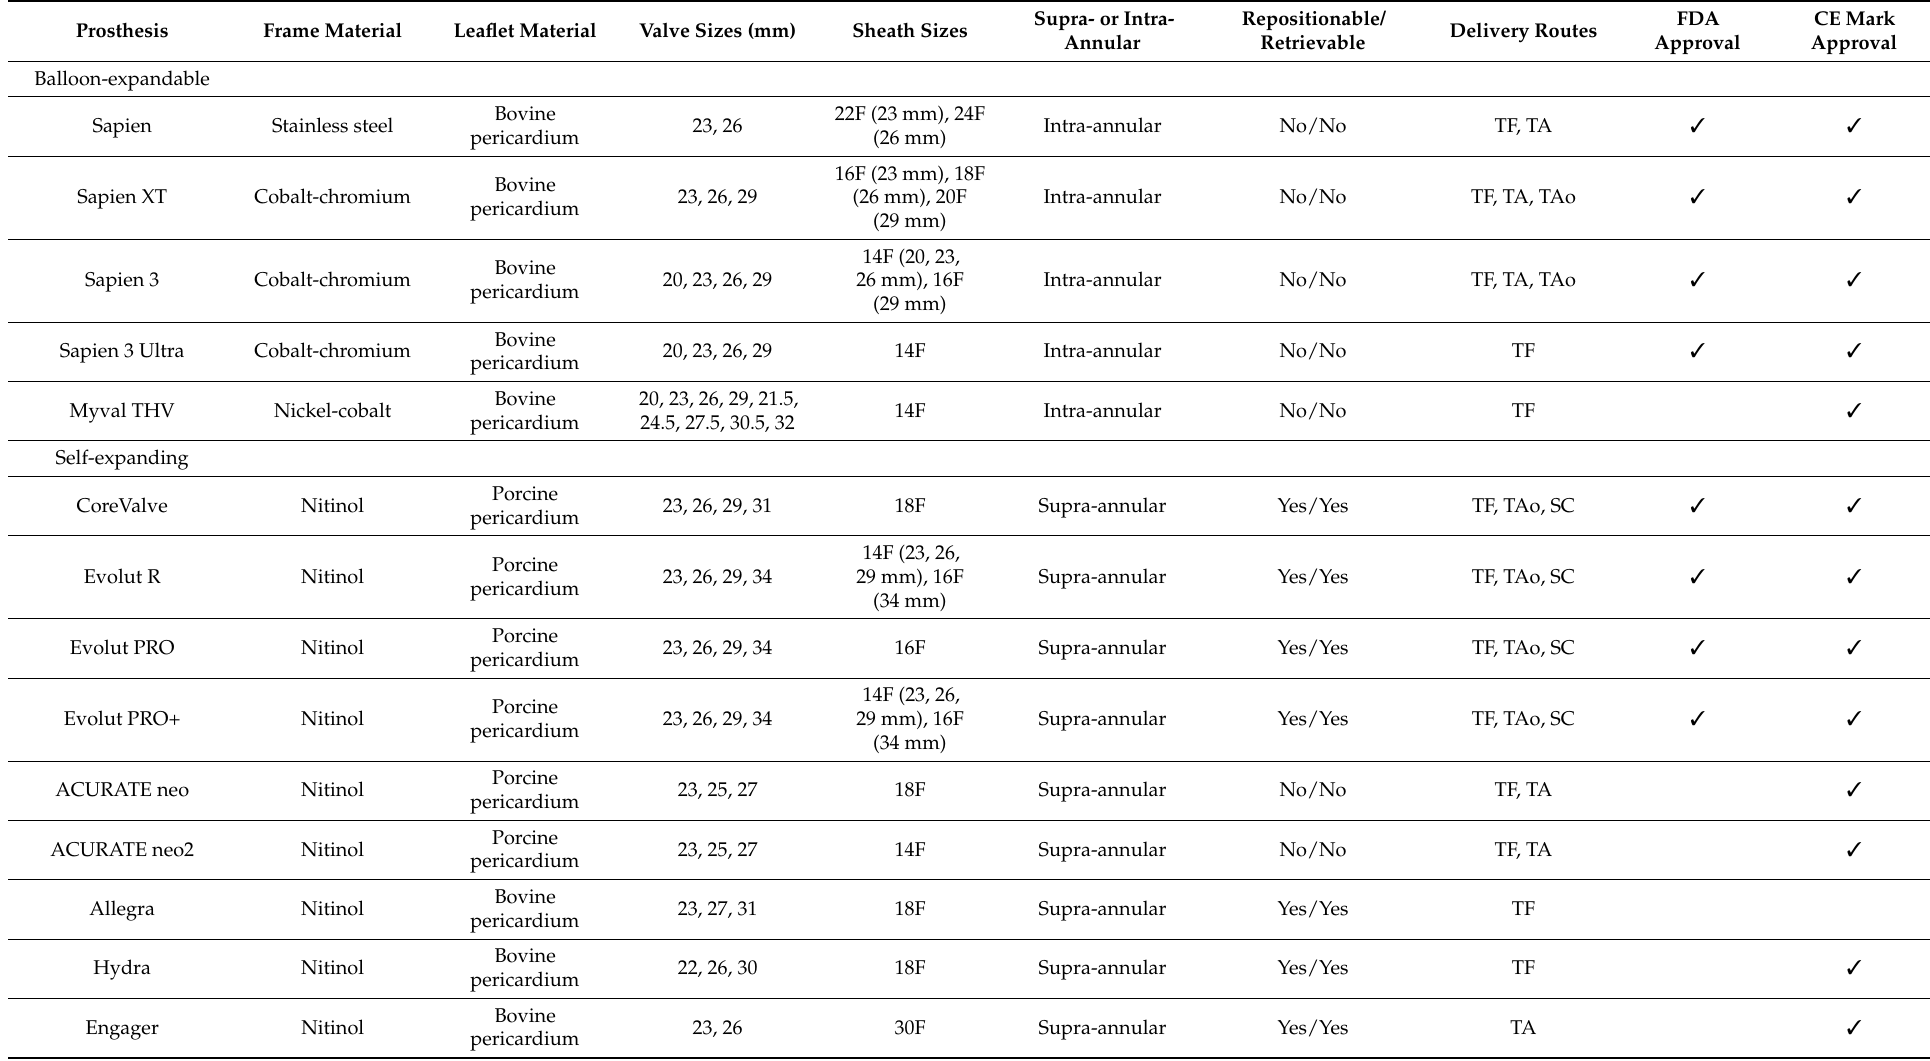
Table 1. Overview of Transcatheter Aortic Valve Replacement (TAVR)